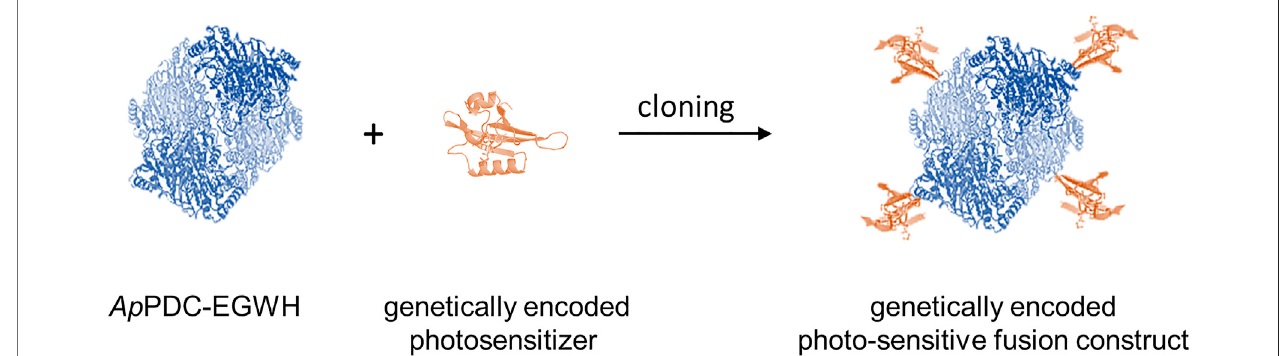
FIGURE 2 | Schematic representation ofthe construction of genetically encoded fusions between photosensitizers (symbolized by the structure of SOPP) and the enzyme Ap PDC-EGWH. Orange: monomeric photosensitizer subunits; blue: tetrameric Ap PDC-EGWH.